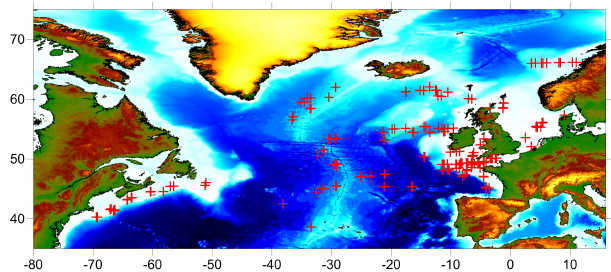
Figure 6. Jellyfish swarms recorded by the Continuous Plankton Recorder in